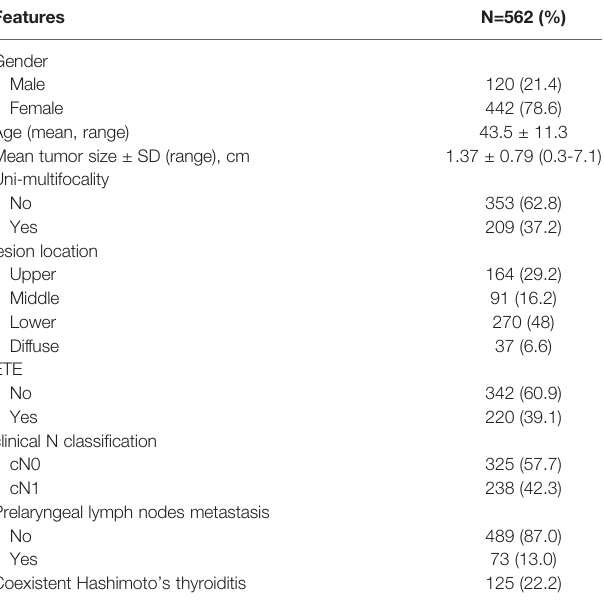
TABLE 1 | Baseline data of 562 PTC patients.